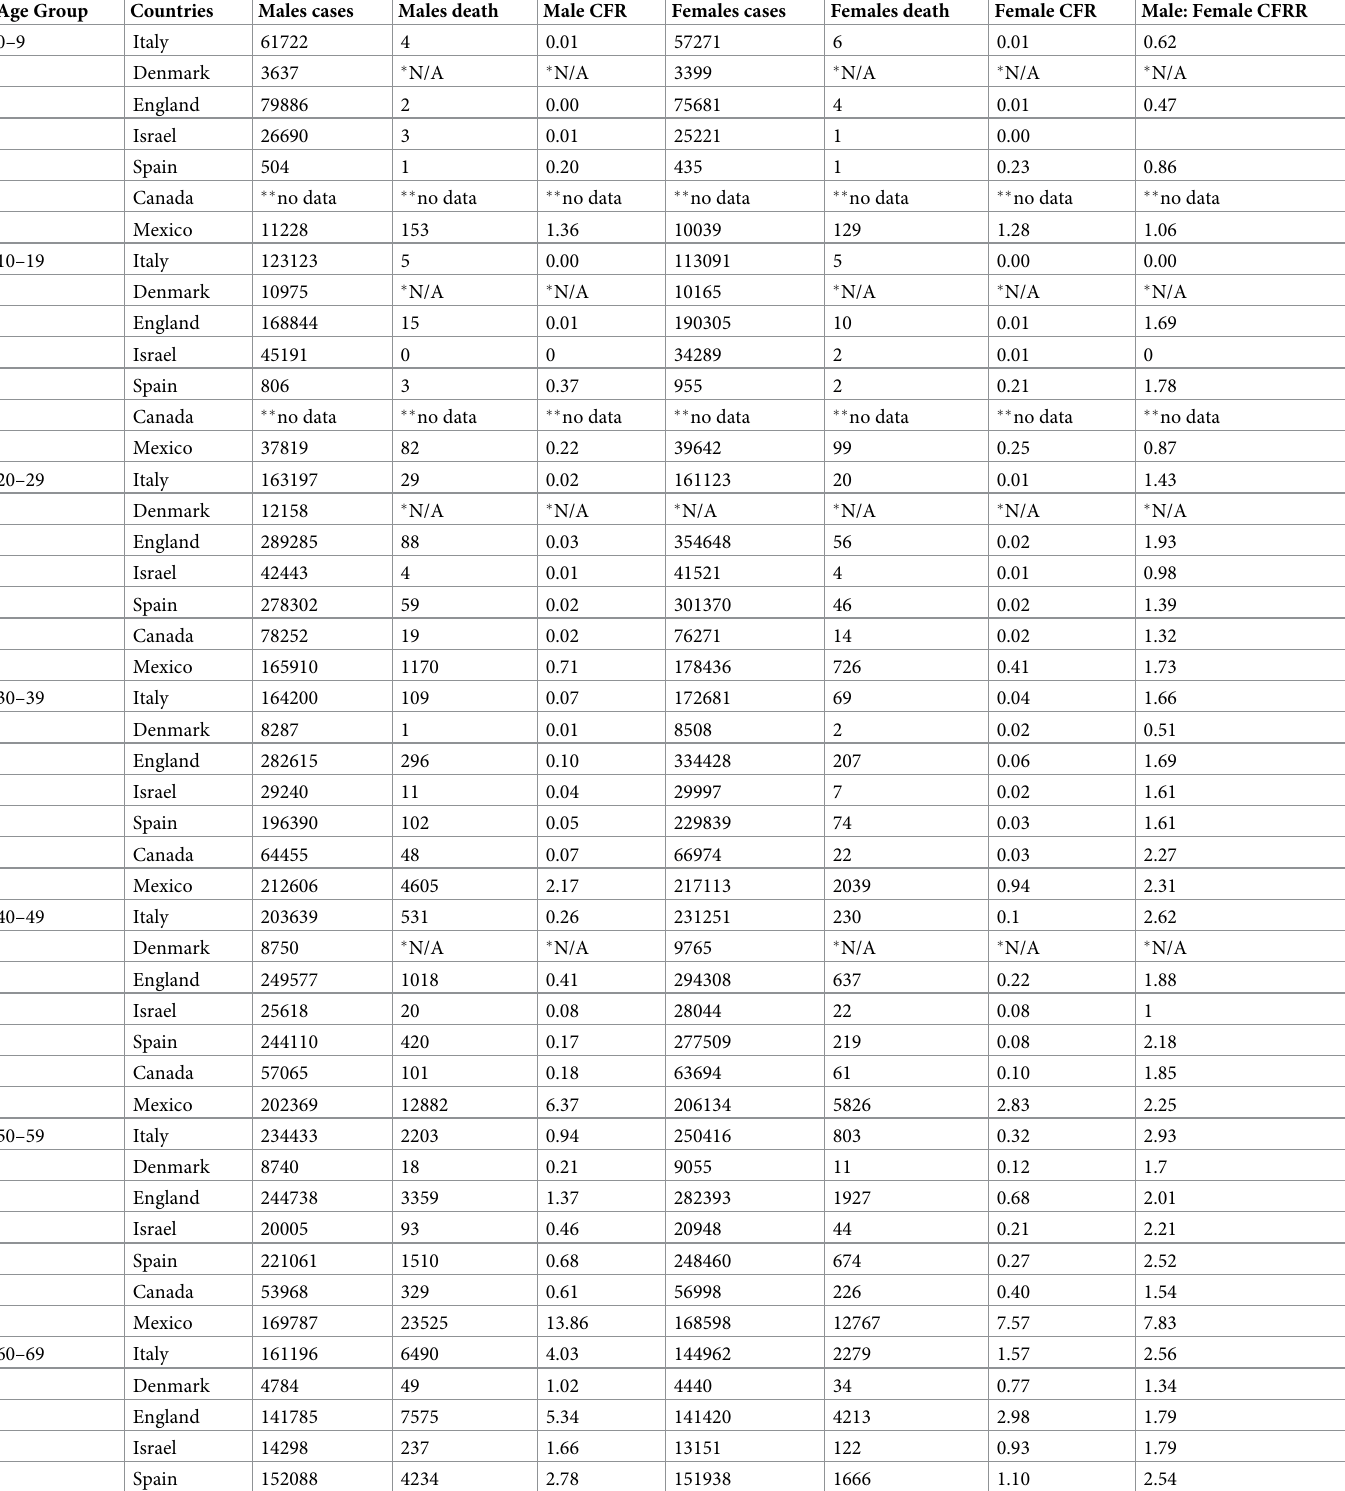
Table 1. Cases, deaths, CFRs (%) (by age group and sex) and male to female CFRRs (%). Age